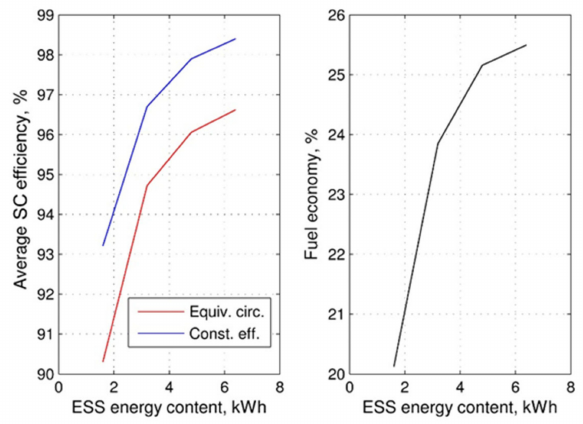
Figure 14. Influence of the ESS energy content on the supercapacitor e ffi ciency and relative fuel economy.